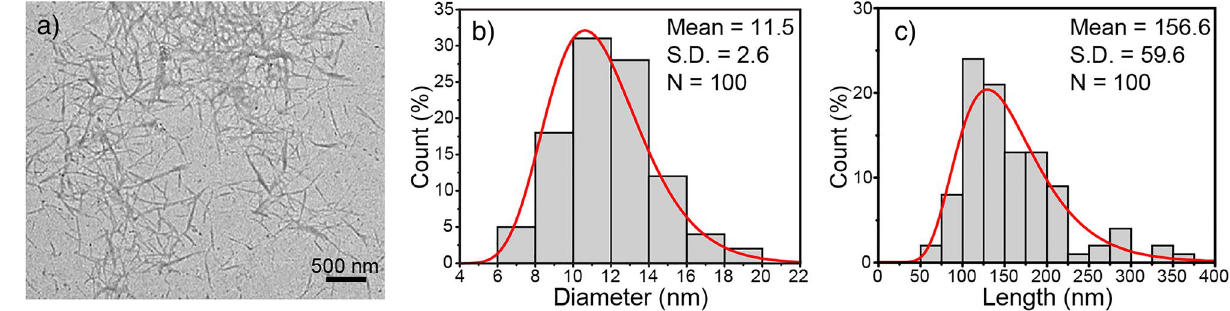
Figure 2. Morphology and size distribution of XCNC; ( a ) TEM image, ( b ) diameter distribution, and ( c ) length distribution.